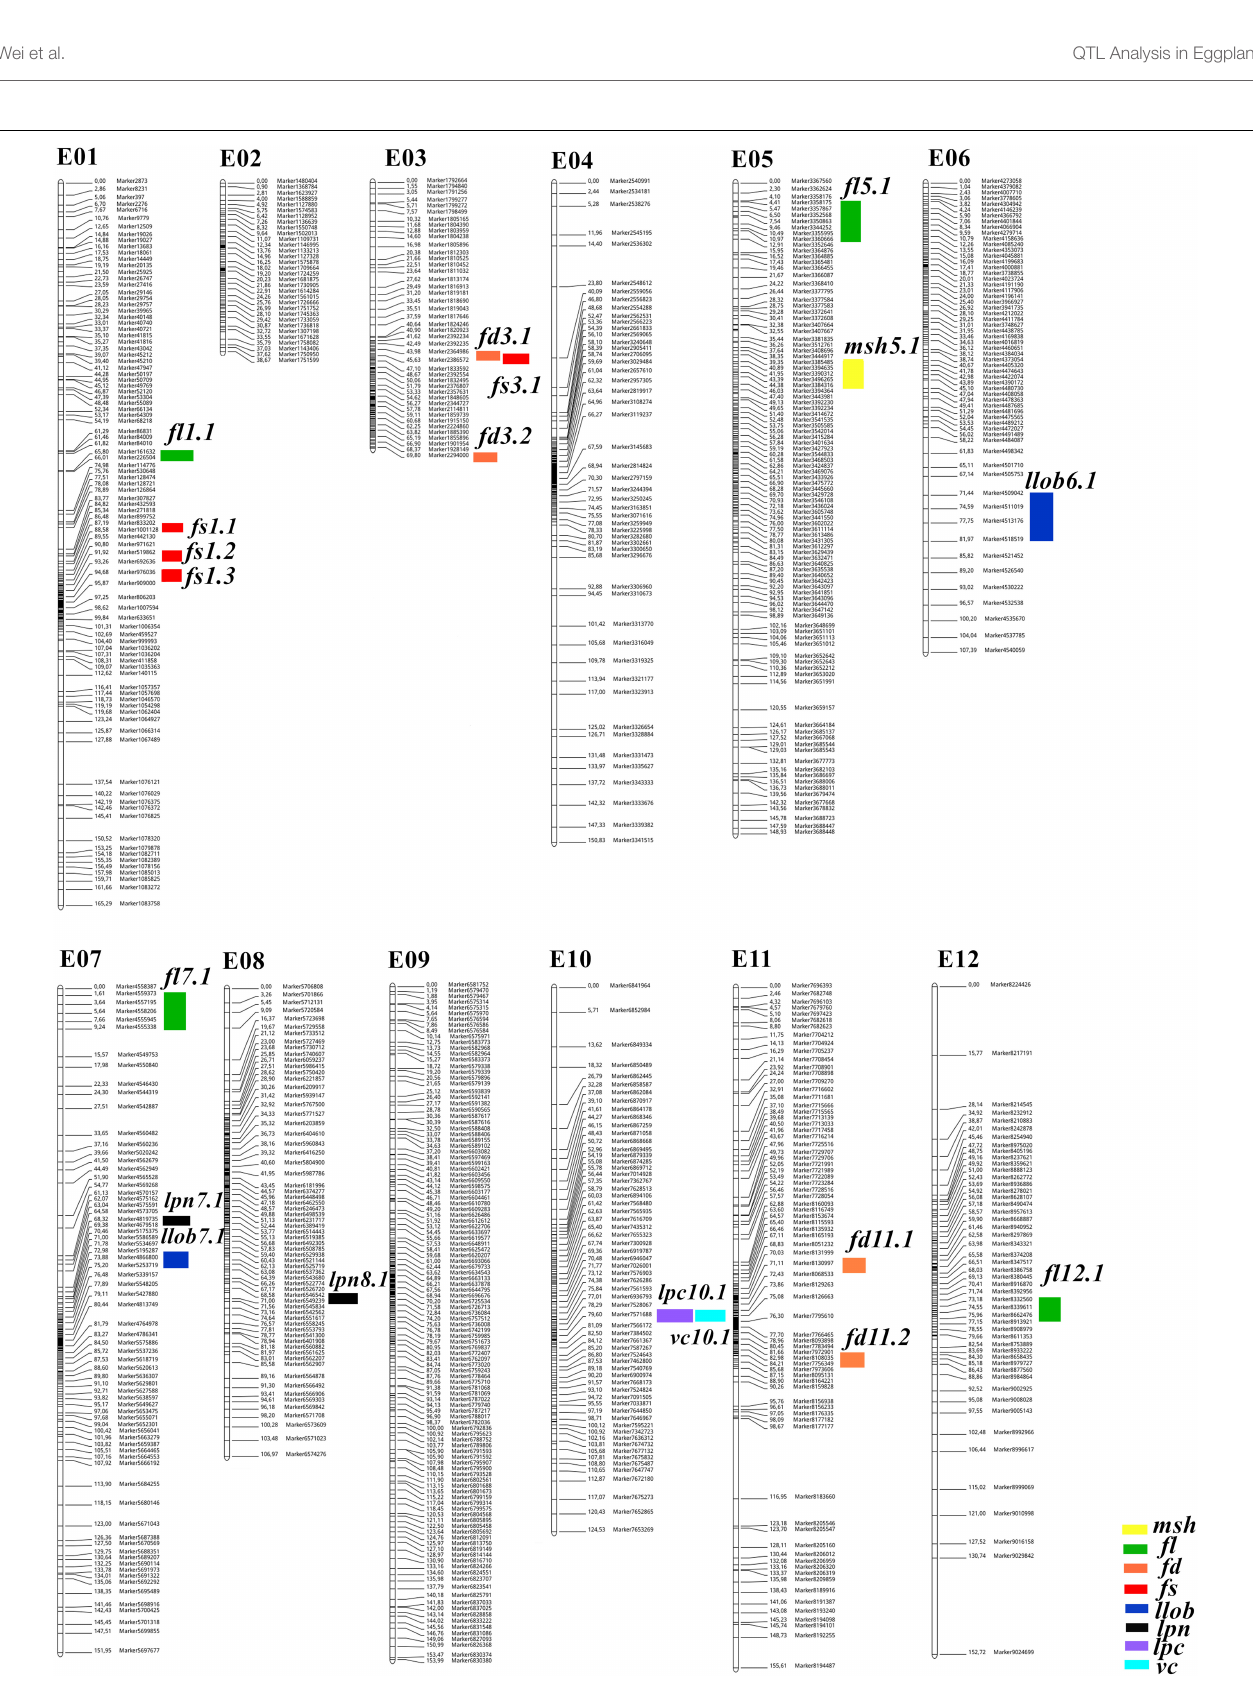
Frontiers in Genetics |